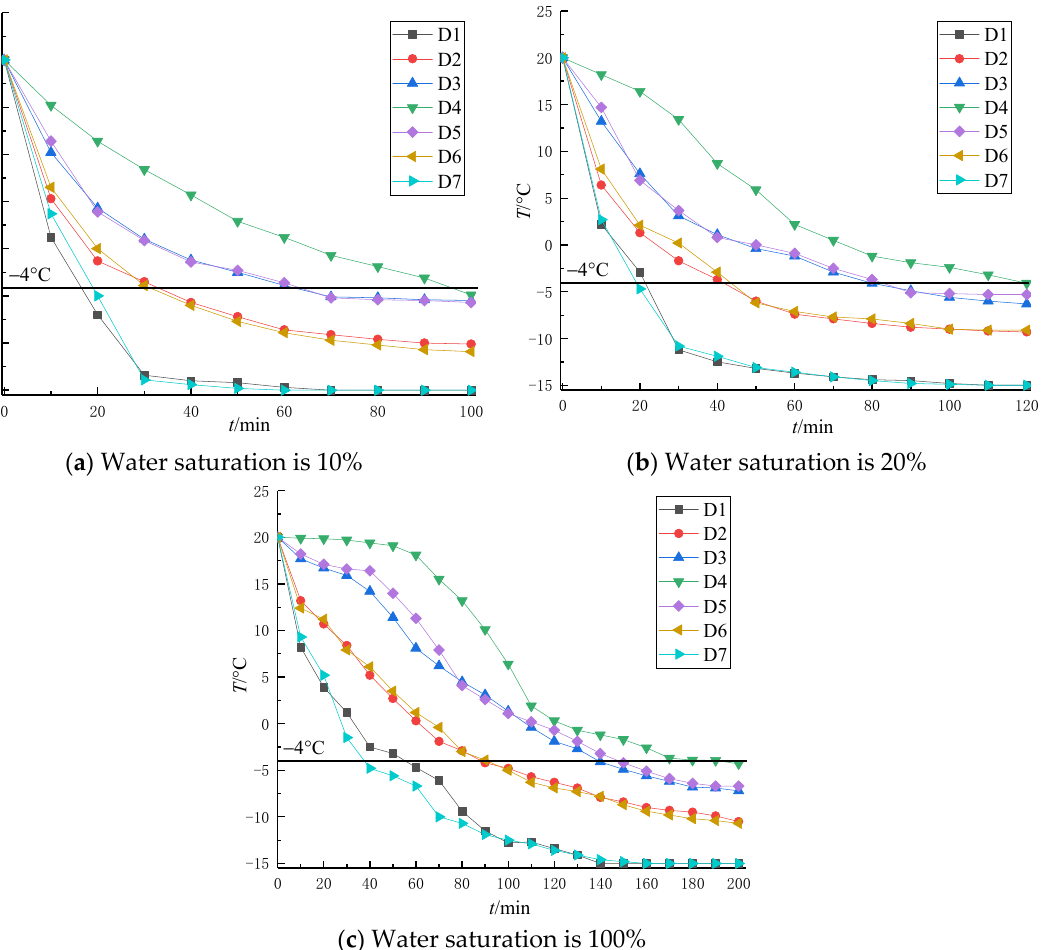
Figure 4. Temperature changes of electronic thermometers under different water saturation conditions.